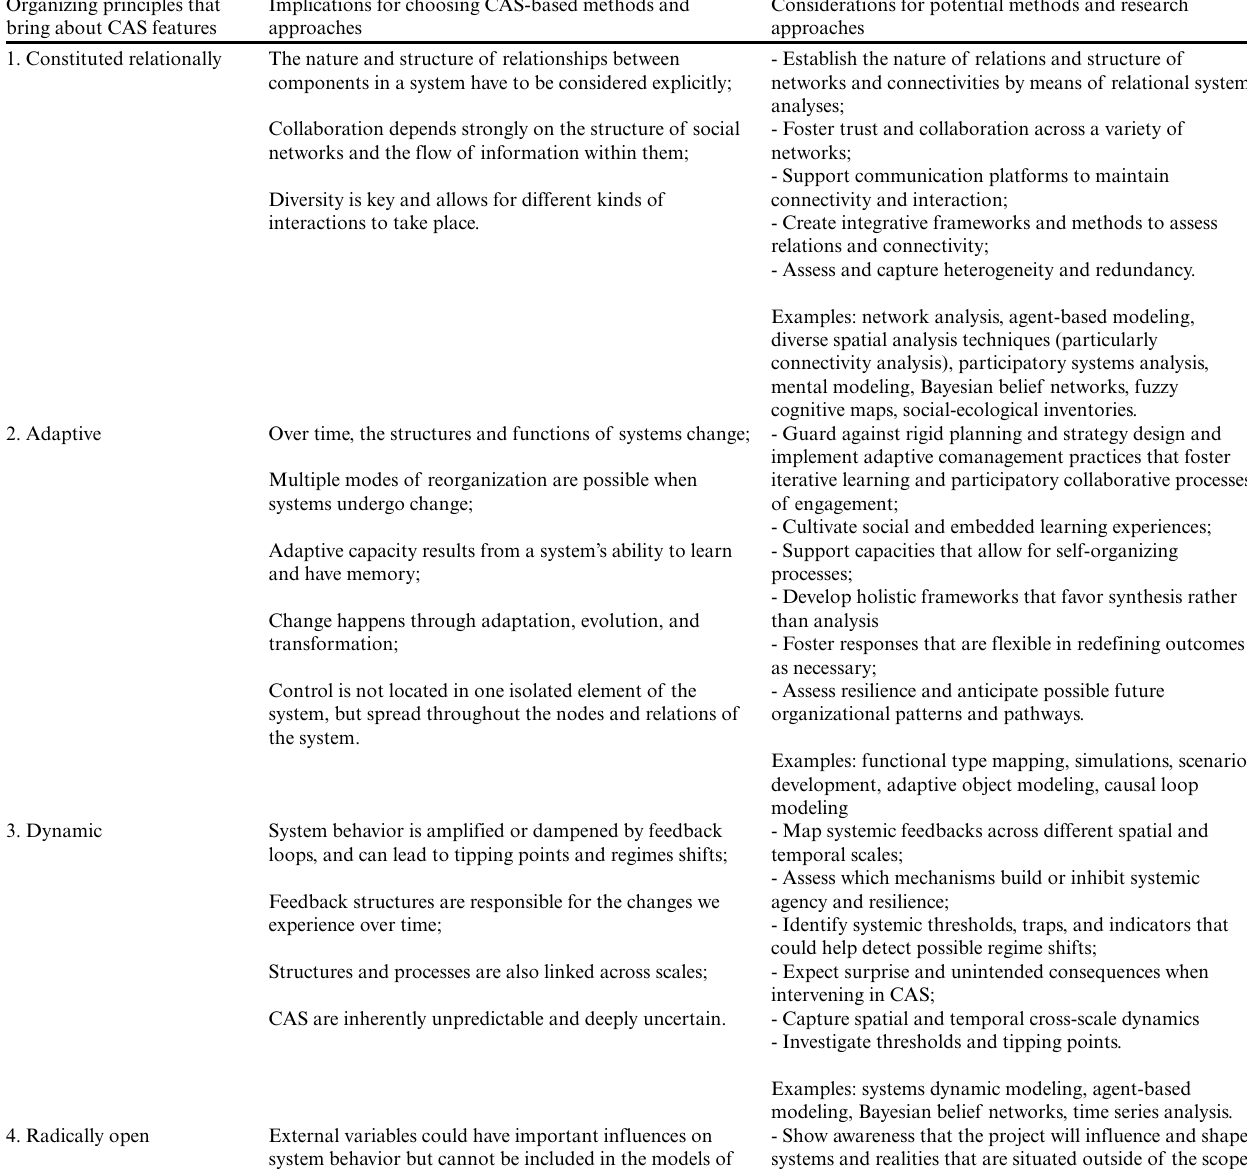
Table 4 . Key implications of the six organizing principles for choosing potential complex adaptive systems (CAS)-based methods and